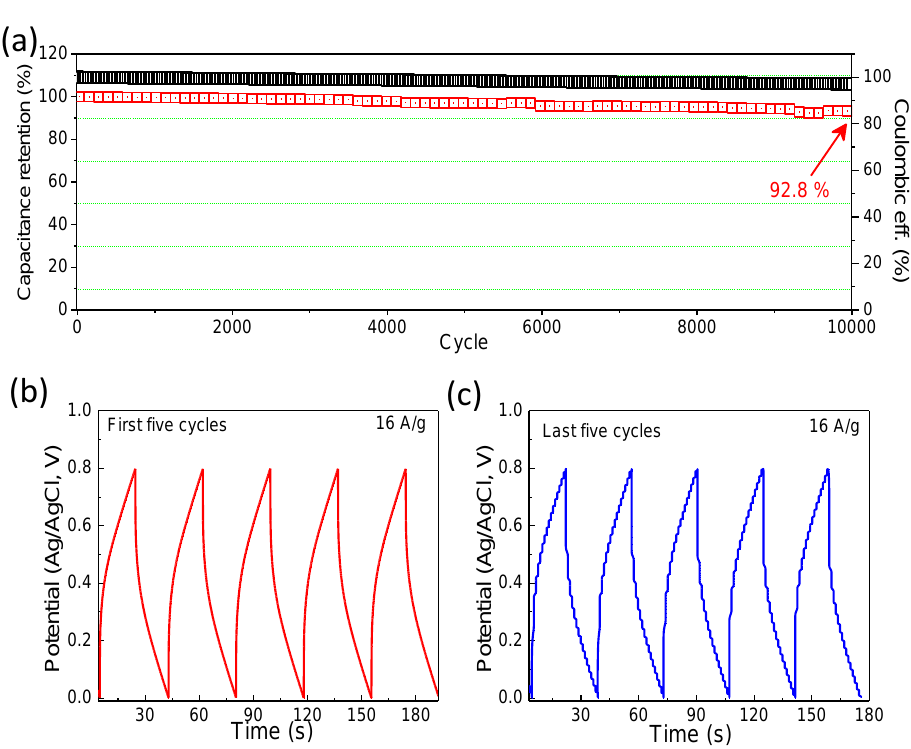
Figure 7. ( a ) Cycling performance of MnO 2 -NPs@CC and CD characteristics for the ( b ) initial five cycles and ( c ) last five cycles.